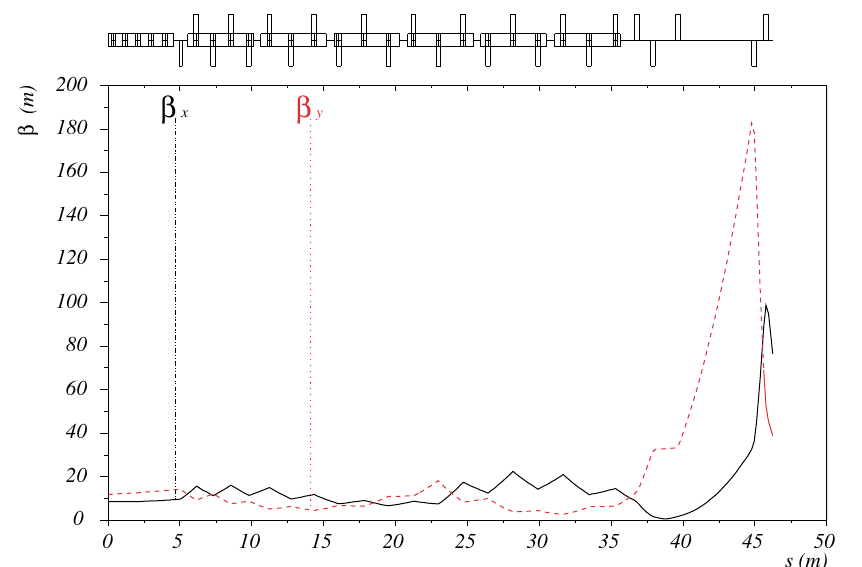
FIG. 6. (Color) Design optics of the linac and the matching section between the exit of the bunching system and the injection line. The horizontal (solid line) and vertical (dashed line) (cid:5) functions are